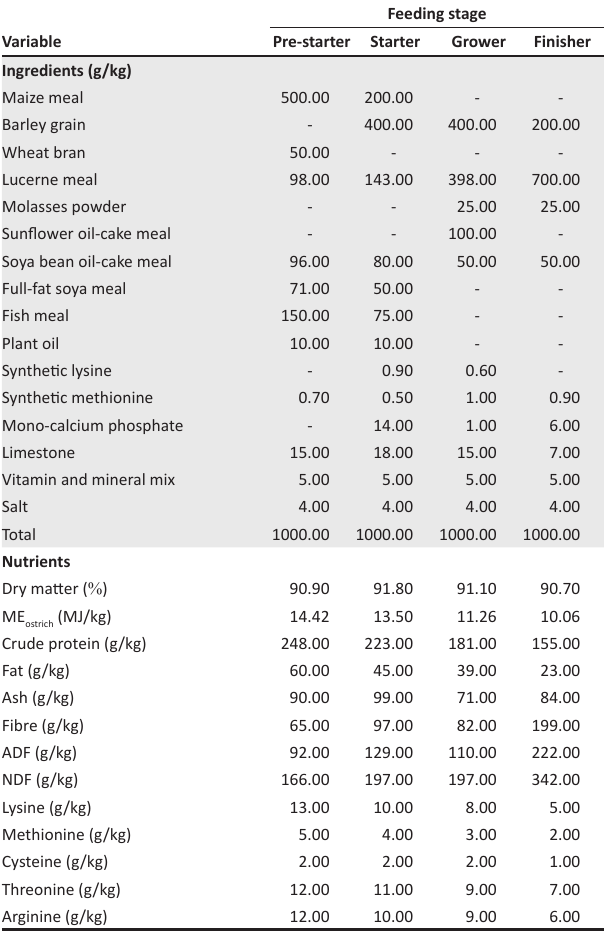
TABLE 1: The feed ingredients and nutrient composition of the formulated feeds fed to the ostriches. Variable